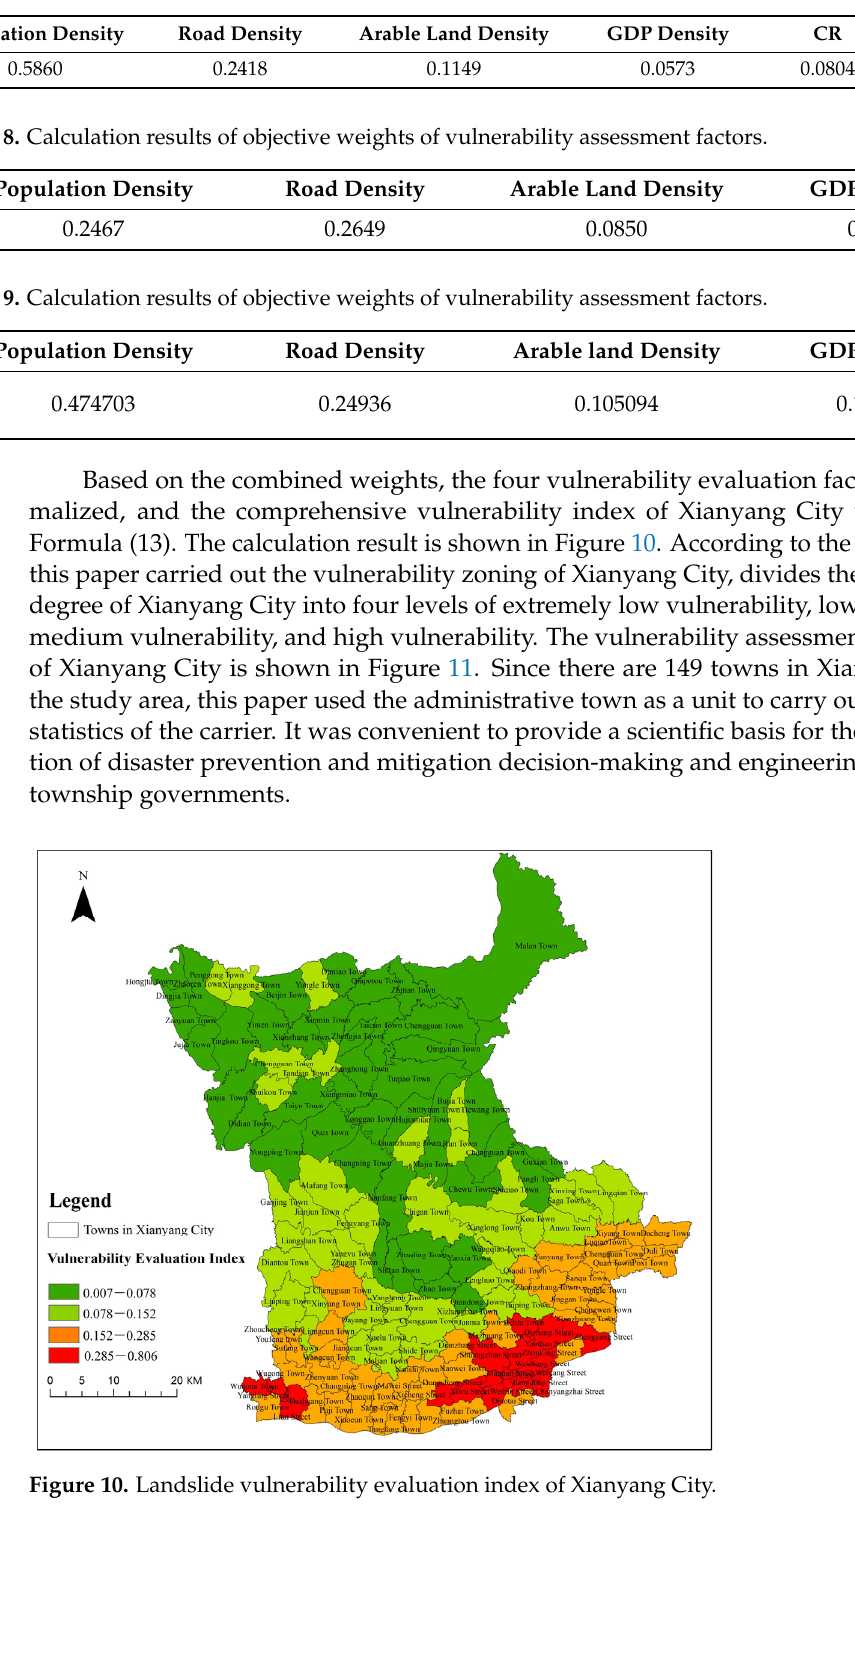
Figure 11. Landslide vulnerability assessment zoning map of Xianyang City.